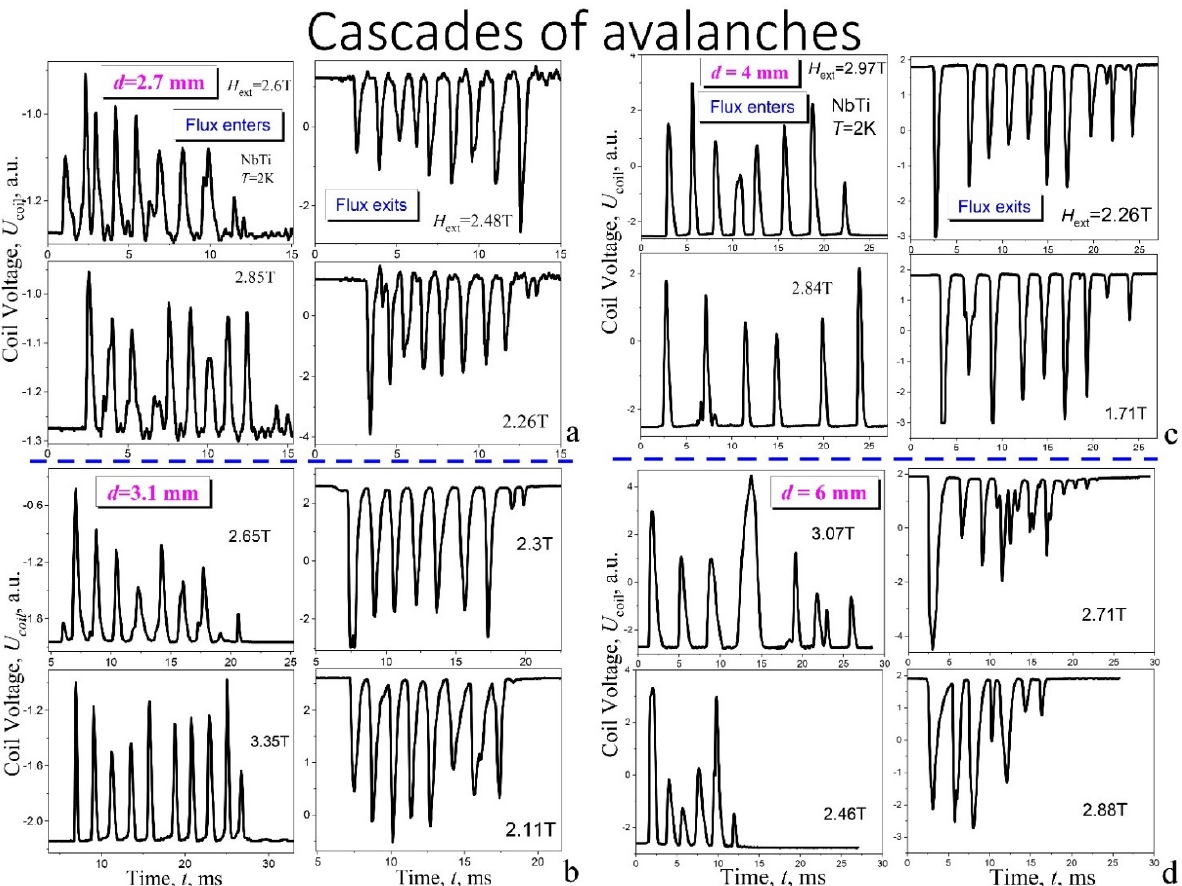
Figure 3. A panorama of the voltage impulses U coil ( t ) at the flux cascades for the plates with various thickness: 2.7 mm ( a ), 3.1 mm ( b ), 4 mm ( c ), and 6 mm ( d ). Each panel presents cascades recorded in four various fields and in the left column there are cascades in screening mode (1st quadrant of hysteresis loops) while in the right one—in trapped mode (2nd